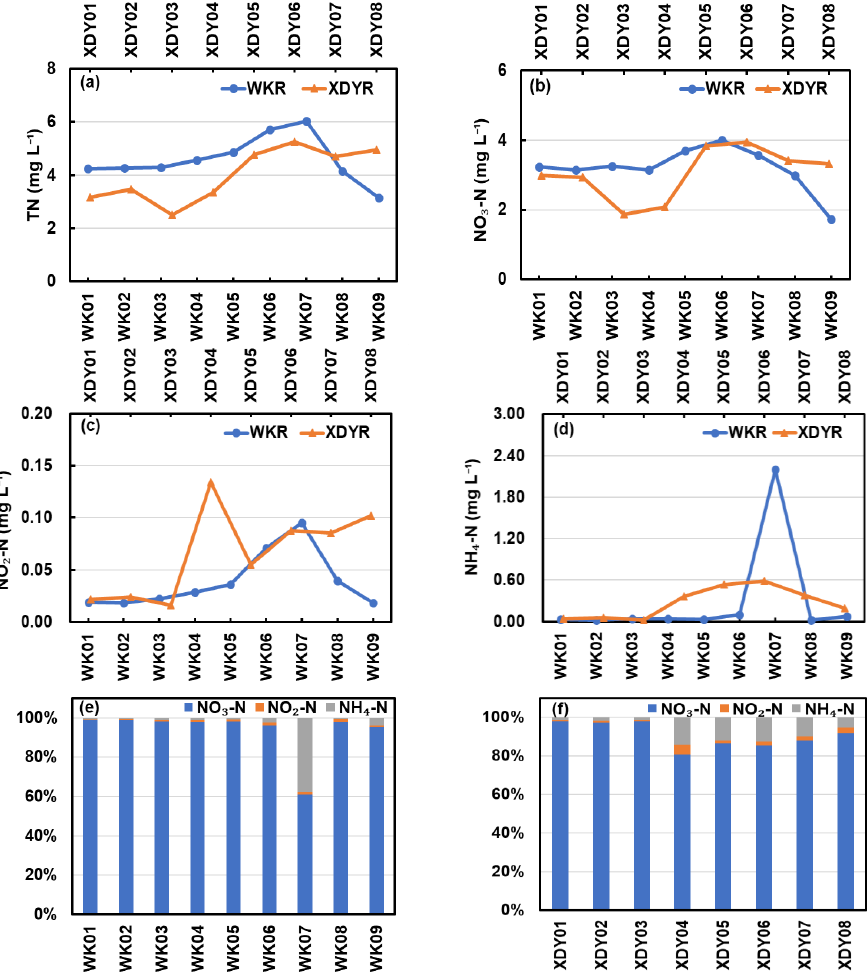
Figure 4. Spatial distribution of ( a ) total nitrogen (TN), ( b ) nitrate nitrogen (NO 3 -N), ( c ) nitrite nitrogen (NO 2 -N), and ( d ) ammonium nitrogen (NH 4 -N) of the sampling sites in the WangKuai reservoir route (WKR) and XiDaYang reservoir route (XDYR), and the percentages of NO 3 -N, NO 2 -N, and NH 4 -N in DIN in ( e ) the WKR and ( f ) the